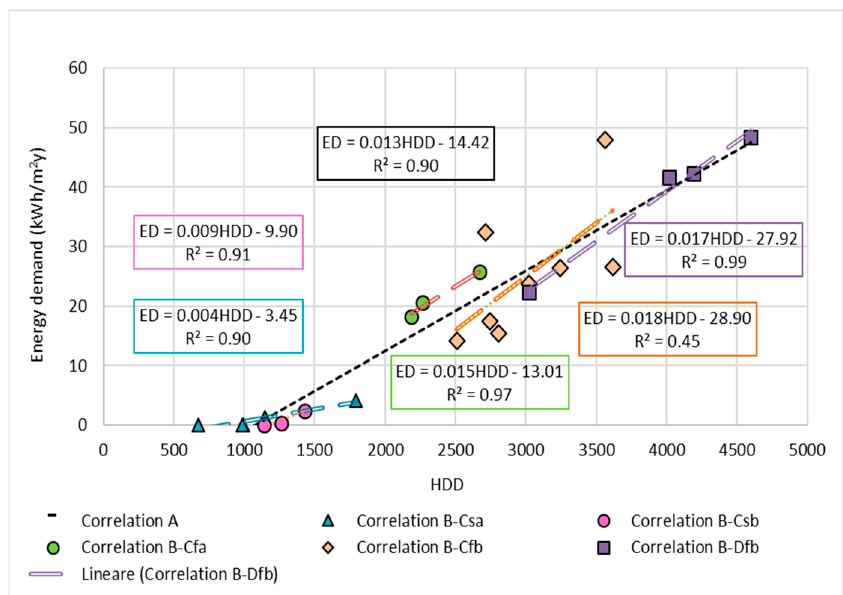
Figure 6. Example of the linear correlation analysis, for the case study Building 3, well insulated envelope, and heating conditions.